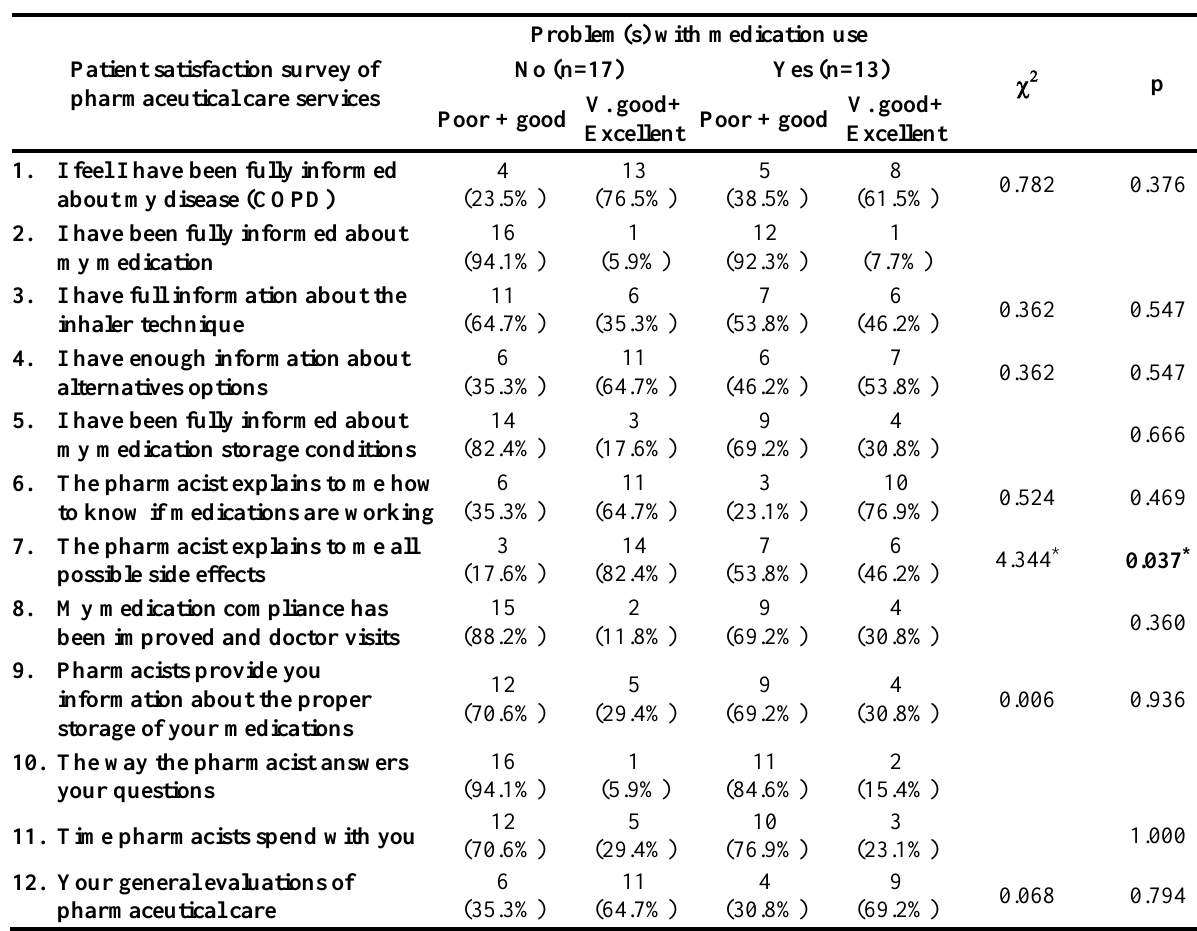
Table 4. Relation between a problem with medication use and patient satisfaction survey of pharmaceutical care services